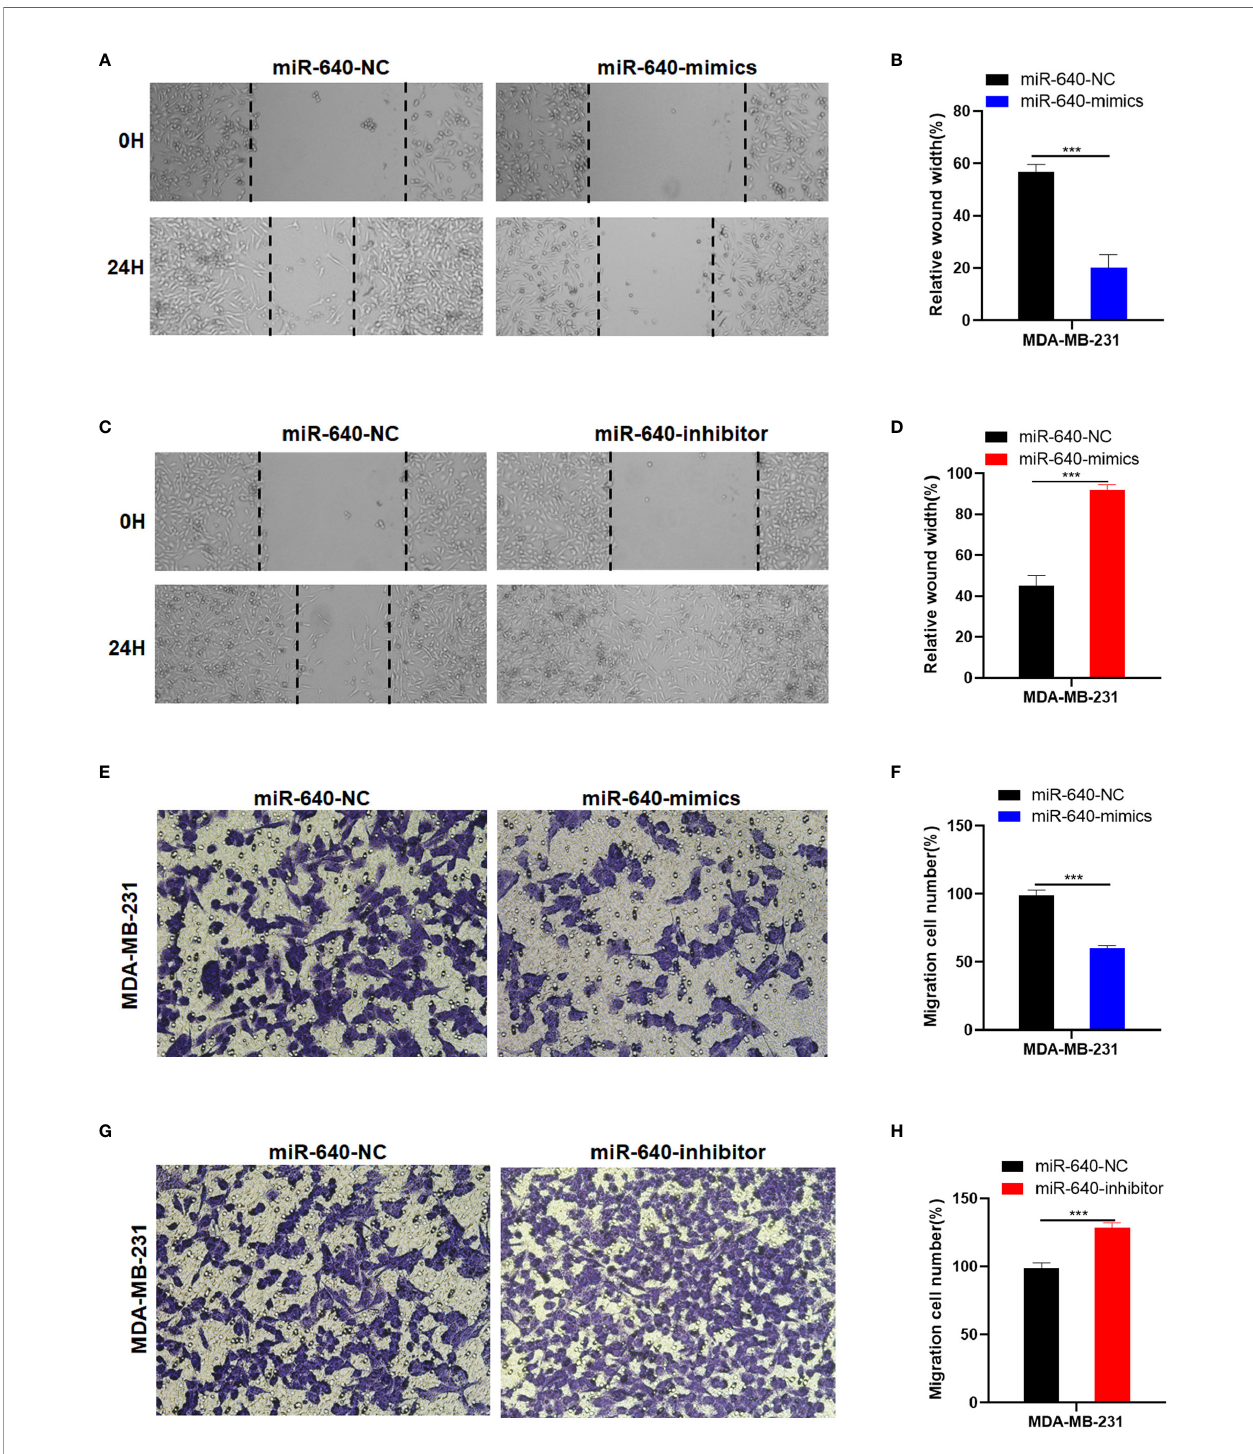
FIGURE 3 | MiR-640 suppressed cell migration of BC cells. (A – D) Wound healing assays were performed in MDA-MB-231 cell line treated with miR-640-mimics or miR-640-inhibitor (miR-NC as negative control). (D – H) Cell migration assays were performed in MDA-MB-231 cell line treated with miR-640-mimics or miR-640- inhibitor (miR-NC as negative control). ***p <